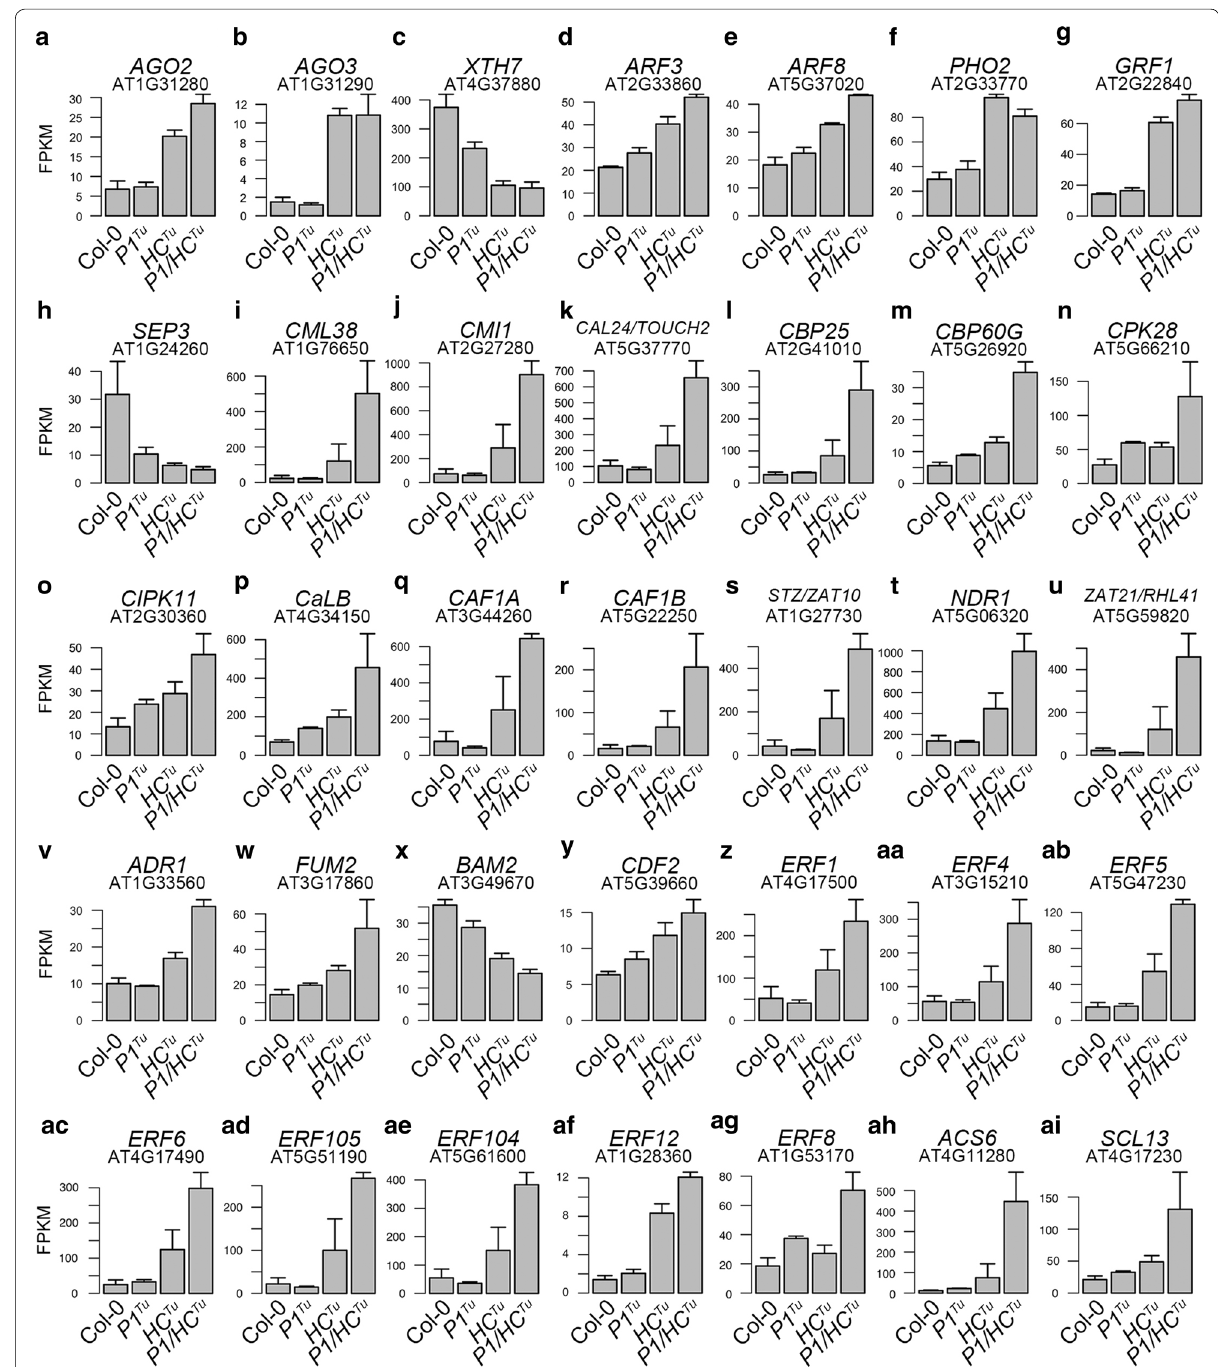
Fig. 8 Transcript expression comparisons of critical genes in the networks. ( a‑ai ) Genes that showed a significant connection, function, or position in the network were selected to demonstrate their transcript expression. The fragments per kilobase of transcript per million (FPKM) were used to represent the normalized transcript expression. The bars represent standard deviations ( n =